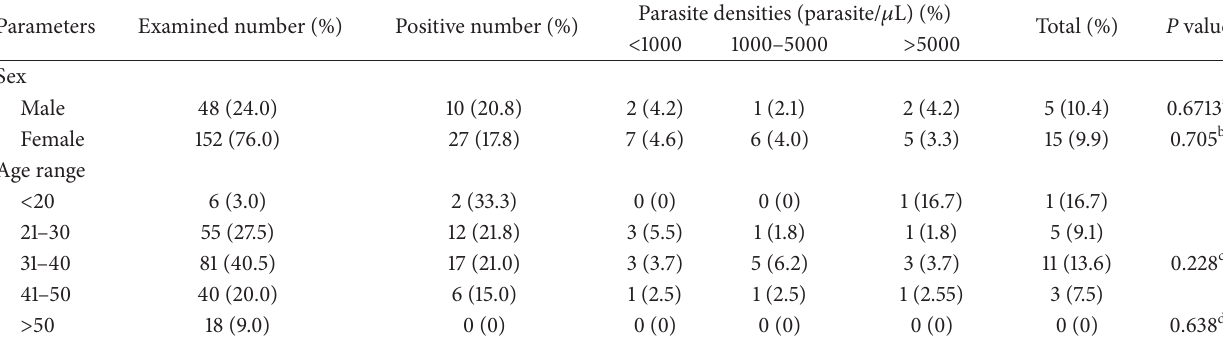
Table 3: Level of parasiteamia with respect to sex and age grouping. Parameters